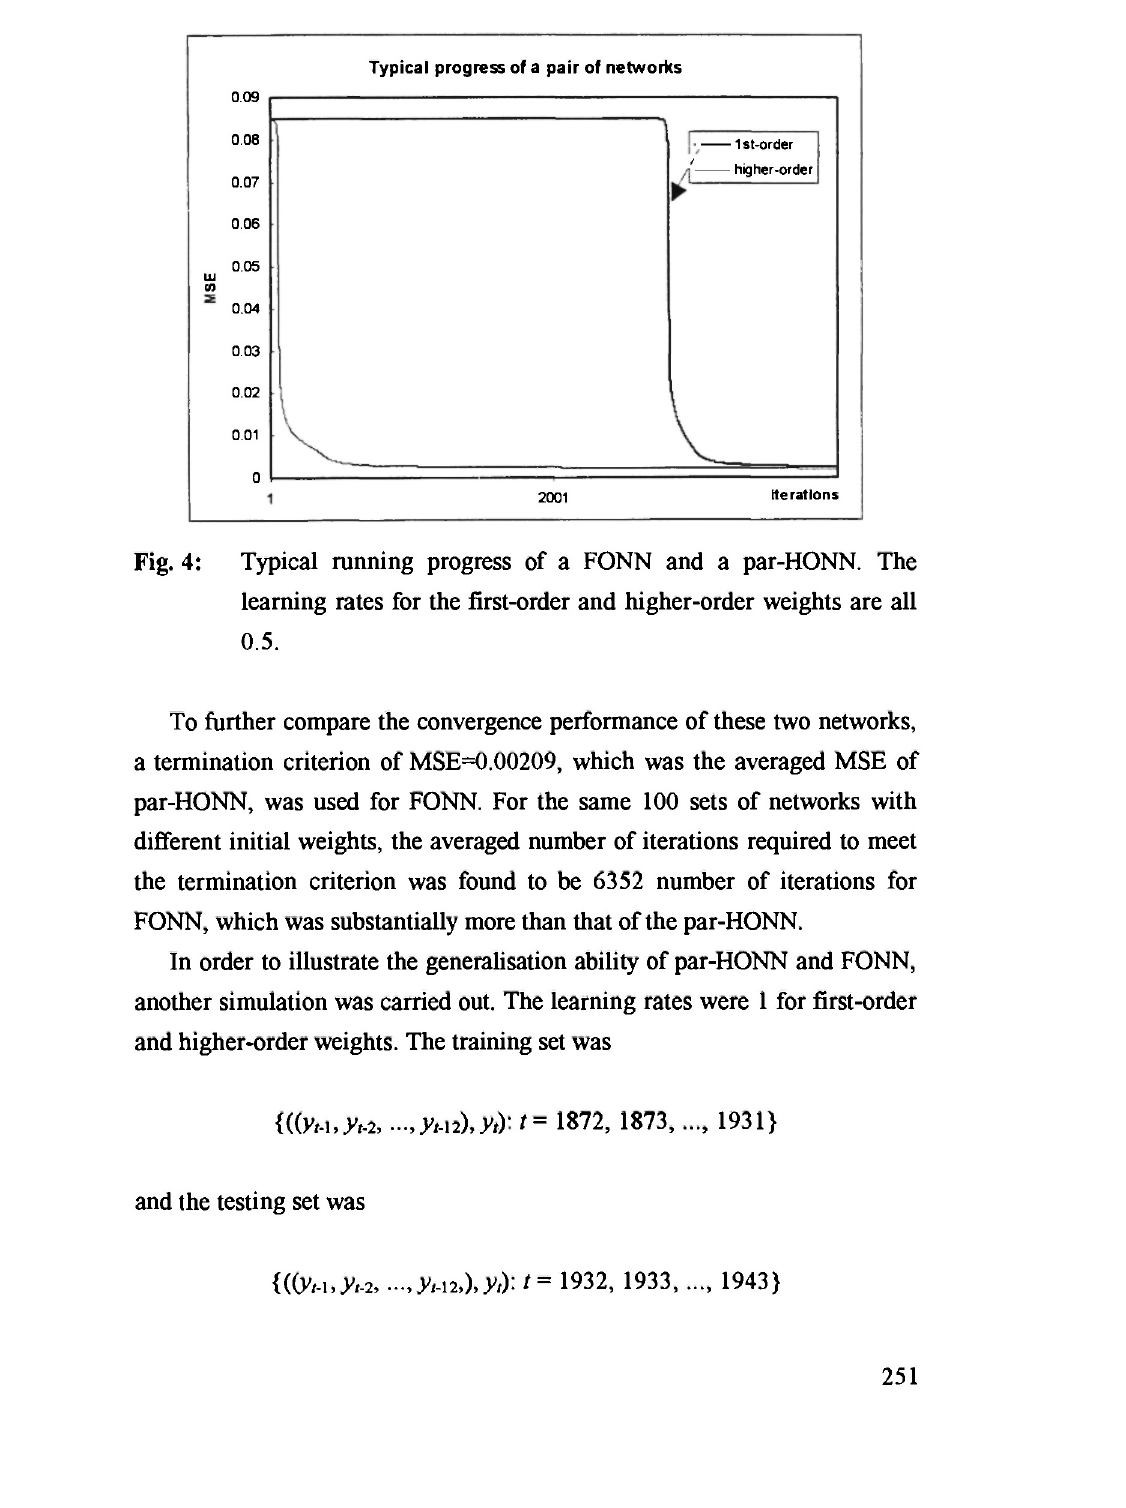
Fig. 4: Typical running progress of a FONN and a par-HONN. The learning rates for the first-order and higher-order weights are all